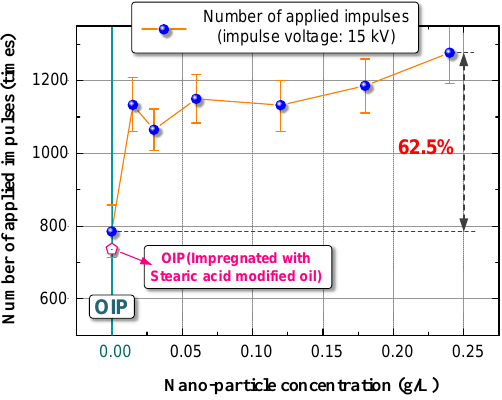
Figure 8. Number of applied impulses before breakdown occur for OIP and